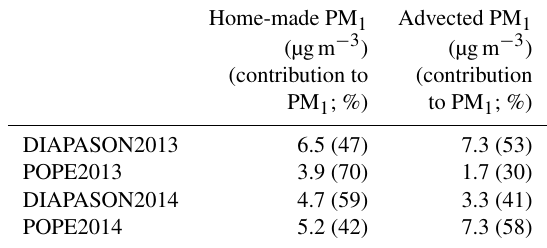
Table 4. Estimated contribution of home-made and advected species to total PM 1 for all measurement periods. Dust advection periods and emissions from cigarettes are